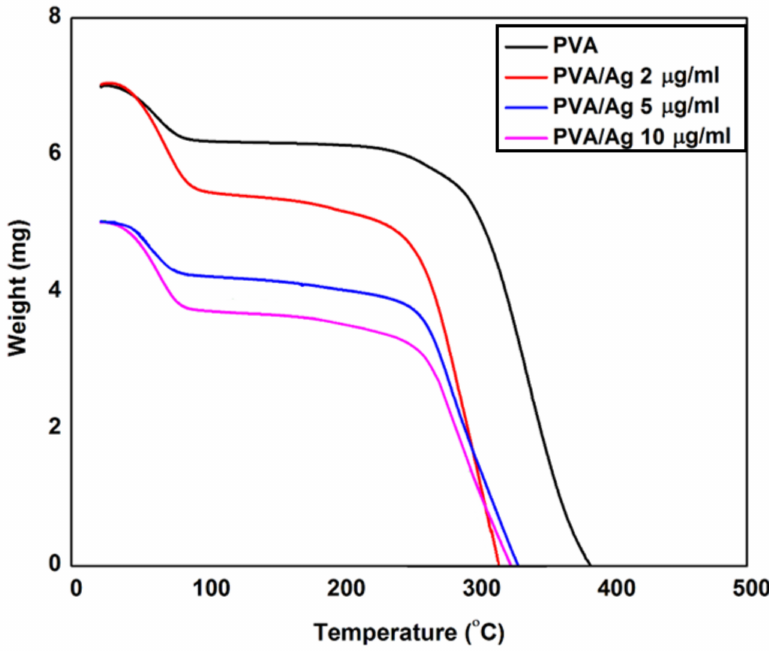
Figure 4. TGA analysis for electrospun PVA nanofibers embedded with different Ag NPs concentra- tions.